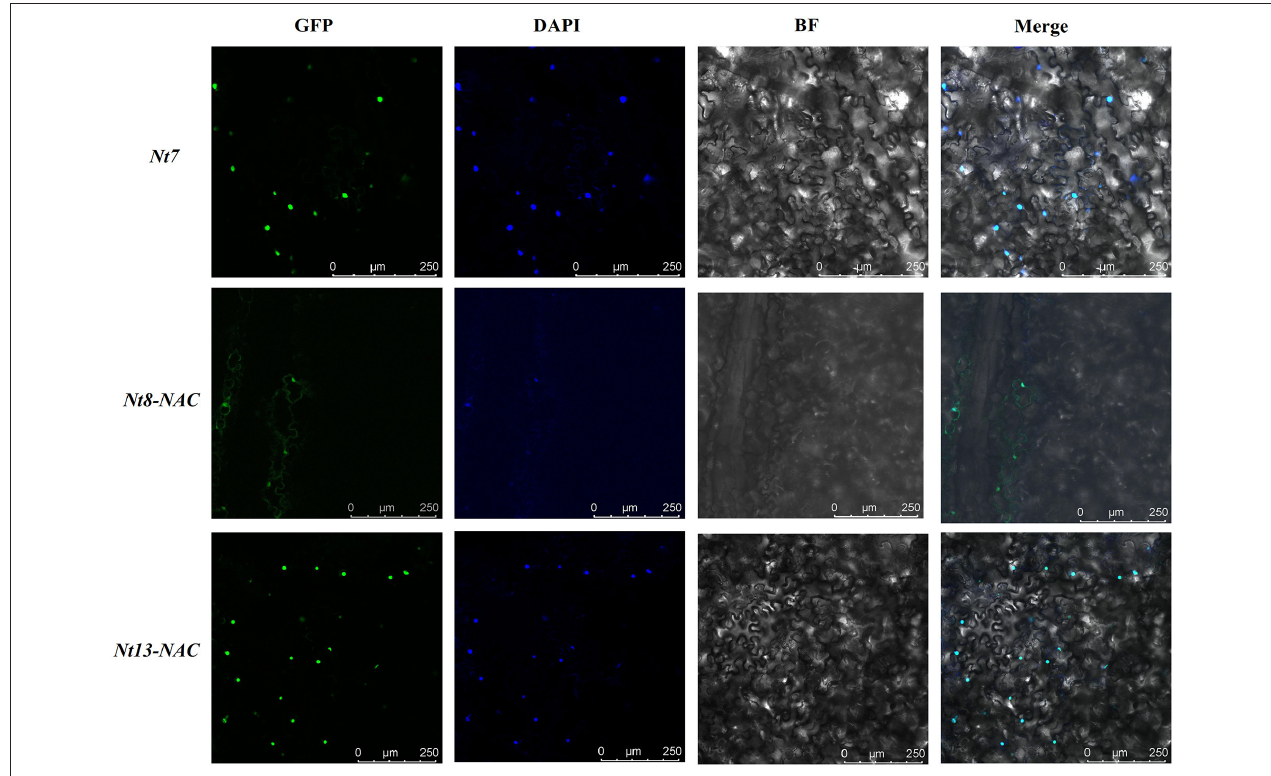
FIGURE 8 | Subcellular localization of Nt7 and the NAC domain of Nt8 and Nt13 . The fusion constructs and green fluorescent protein (GFP) driven by the 35S promoter were transiently expressed in tobacco. DNA dye 4,6-diamidino-2-phenylindole (DAPI) was used as a nucleus marker, and the green fluorescent signals of these genes can be merged with